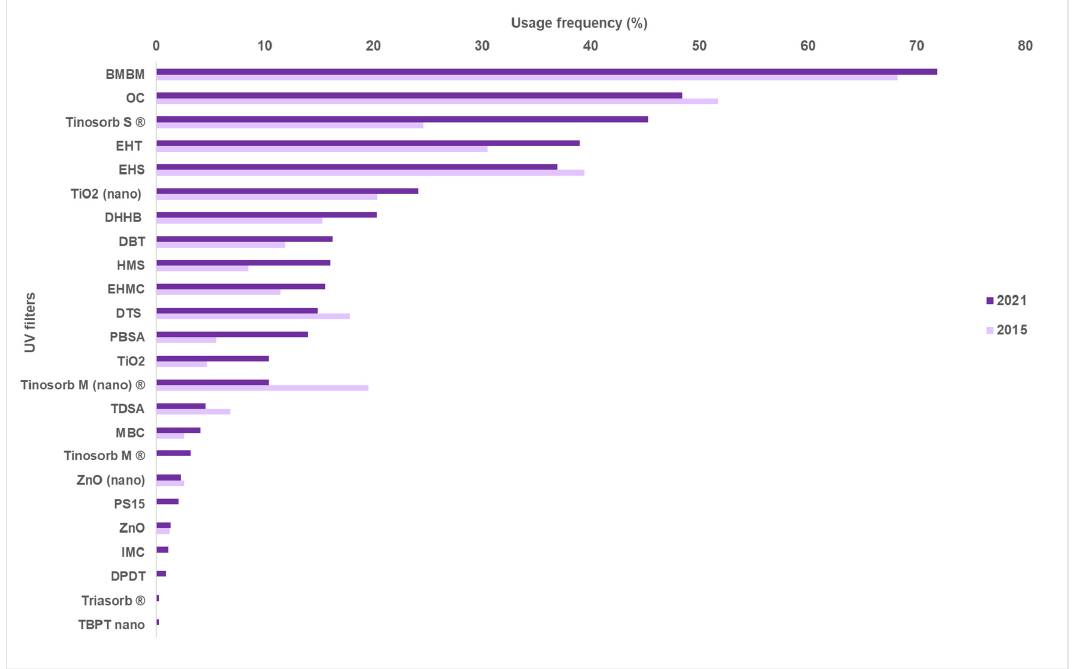
Figure 6. Frequency of use for UV filters found in sunscreens in 2015 and 2021. (BMDBM: butyl methoxydibenzoylmethane, OC: octocrylene, Tinosorb S ® : bis-ethylhexyloxyphenol methoxyphenyl triazine, EHT: ethylhexyl triazone, EHS: ethylhexyl salicylate, DHHB: diethylamino hydroxybenzoyl hexyl benzoate, DBT: diethylhexyl butamido triazone, HMS: homosalate, EHMC: ethylhexyl methoxycinnamate, DTS: dometrizole trisiloxane, PBSA: phenylbenzimidazole sulfonic acid, Tinosorb M ® : methylene bis-benzotriazolyl tetramethylbutylphenol, TDSA: terephthalydidene dicamphor sulfonic acid, MBC: 4-methylbenzylidene camphor, PS15: polysilicone-15, IMC: isoamyl p -methoxycinnamate, DPDT: disodium phenyl dibenzimidazole tetrasulfonate, Triasorb ® : phenylene bis-diphenyltriazine, TBPT: tris-biphenyl triazine.) Four organic UV filters, namely disodium phenyl dibenzimidazole tetrasulfonate (DPDT), phenylene bis-diphenyl triazine (Triasorb ® ), nano tris-biphenyl triazine